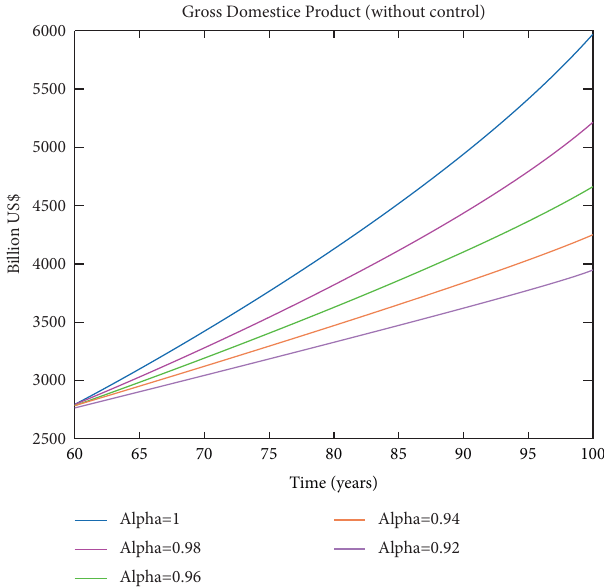
Figure 9: Comparison of GDP without control with diferent values of alpha.